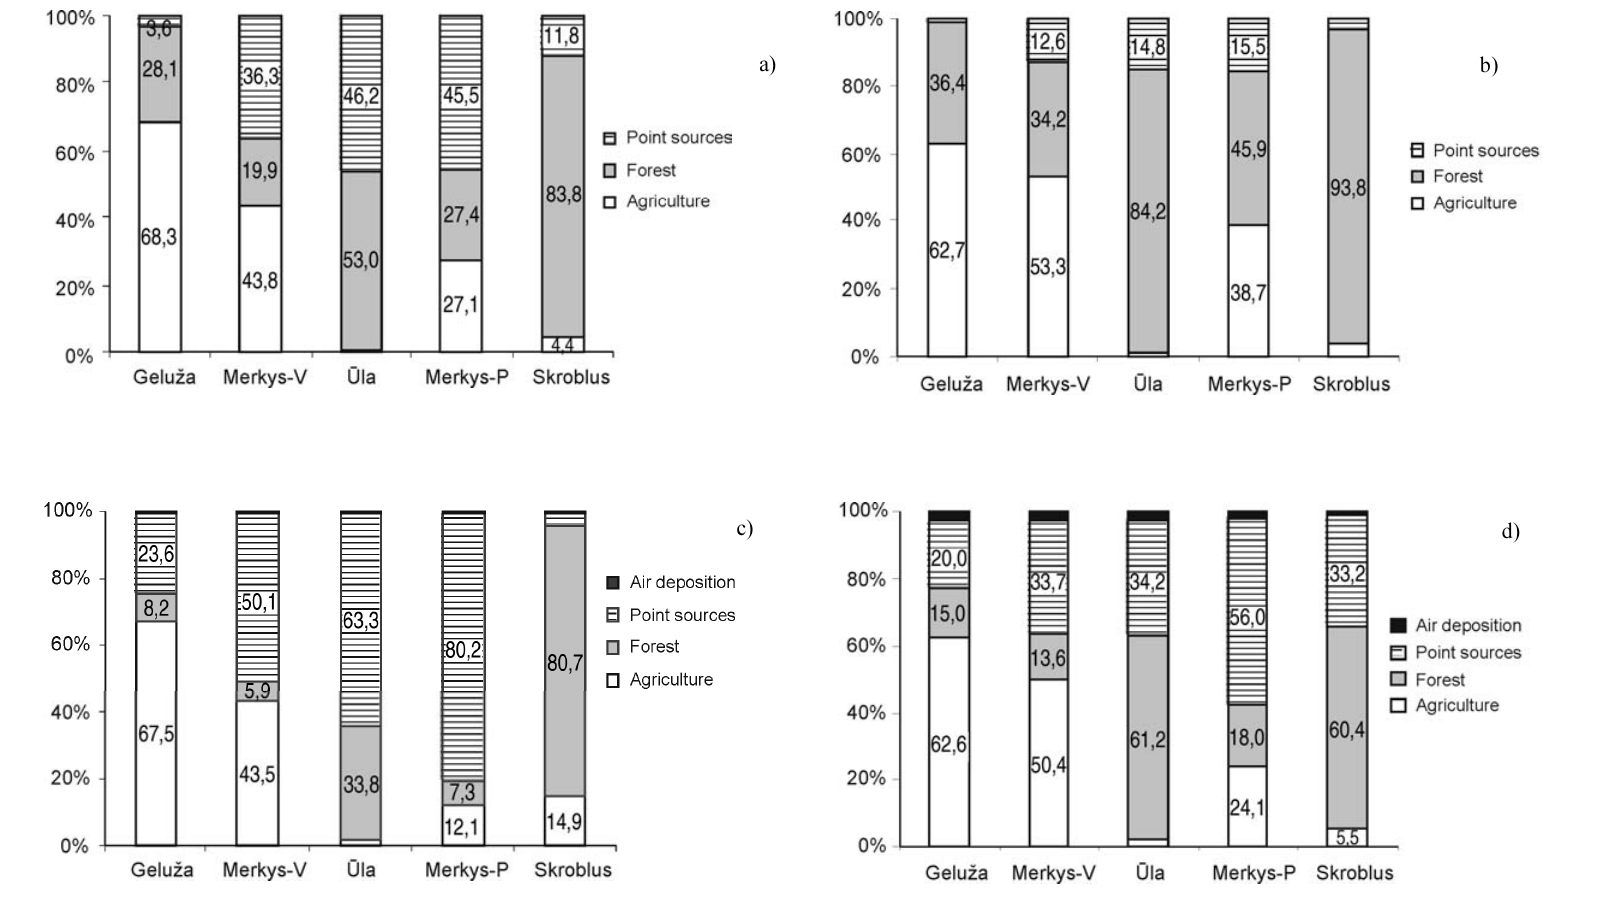
Fig. 4. Source apportionment of COD (a), BOD (b), total nitrogen (c) and total phosphorus (d) in studied